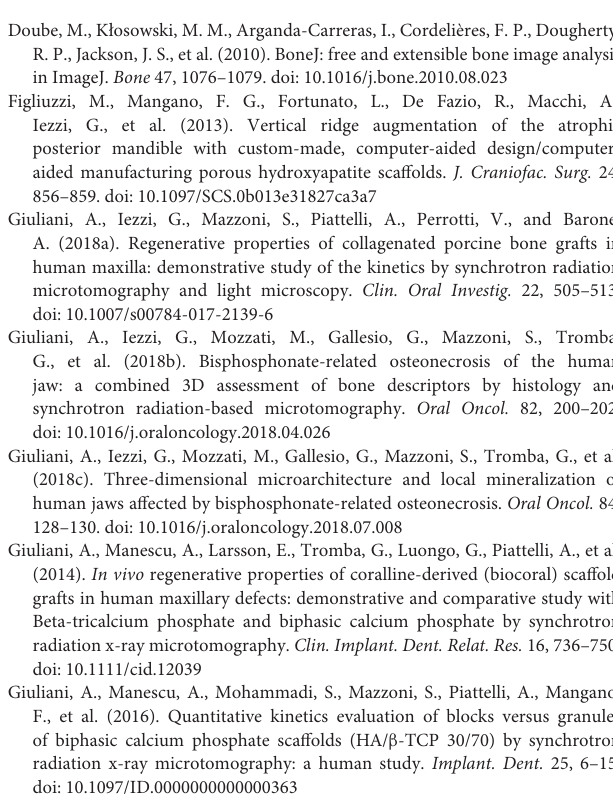
FIGURE 2 | (B) (Acid fuchsin-Toluidine blue 12X). (B) At higher-power magnification, the biomaterial particles (P) were in tight contact with the mature bone (B) . At the bone-biomaterial particles interface, the particles showed a lower density (black arrows) compared to their central portion (Acid fuchsin-Toluidine blue 40X). (C) Close to the residual biomaterial, which revealed signs of resorption (black arrows), a multinucleated giant cell was observed (MC). (D) In the small marrow spaces (MS), some blood vessels (V), and signs of bone remodeling were present (black arrows) (Acid fuchsin-Toluidine blue 200 and 100X). (E) Mature lamellar bone (LB) with small osteocyte lacunae were observed (black arrows) and many secondary osteons were detected (O). (F) Histological section under polarized light. The collagen fibers of the lamellar bone (LB) was oriented in a parallel way in many fields, and close to the biomaterial particles (P) (Acid fuchsin-Toluidine blue